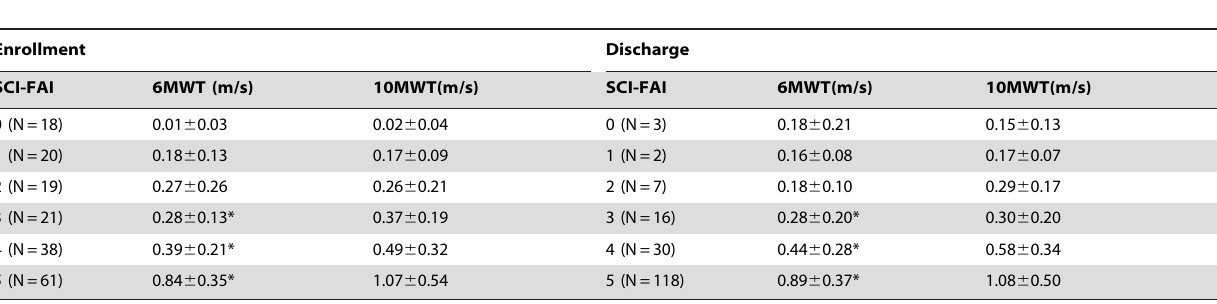
Table 5. Summary statistics for 6MWT and 10MWT at enrollment, discharge, and all evaluations by SCI-FAI Walking Mobility score.